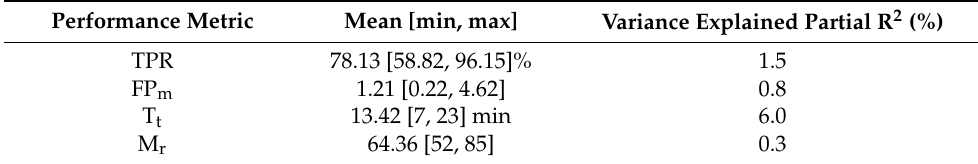
Table 1. BCI performance metrices and percentage of variance explained in MEP amplitudes by each metric.